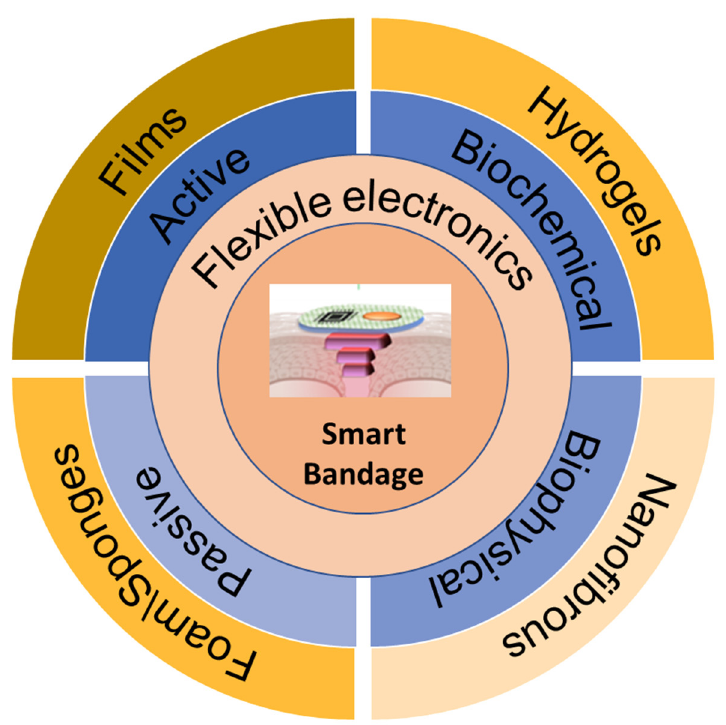
Figure 1. Schematic illustration of the smart bandage structure levels.